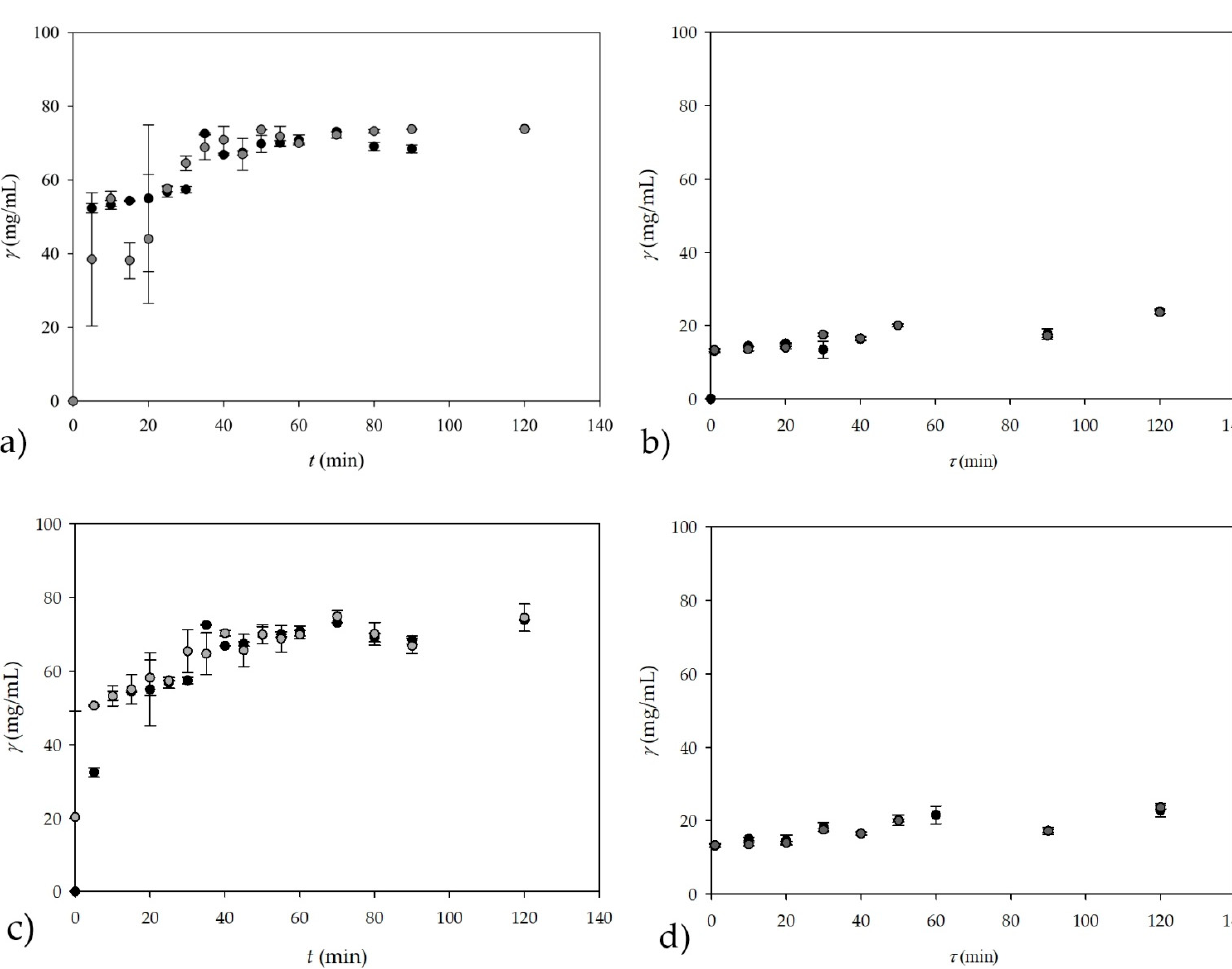
Figure 7. On-line measurement of glycerol concentration by NIR spectroscopy during the transesterification reaction (oil to methanol molar ratio = 1:3.4) carried out ( a ) in a batch reactor; ( b ) in +-shaped microreactor; ( c ) in a batch reactor using subsampling ANN for NIR spectroscopy; and ( d ) in +-shaped microreactor using subsampling ANN for NIR spectroscopy ( ● —calculated, theoretical glycerol, ● —NIR spectroscopy).